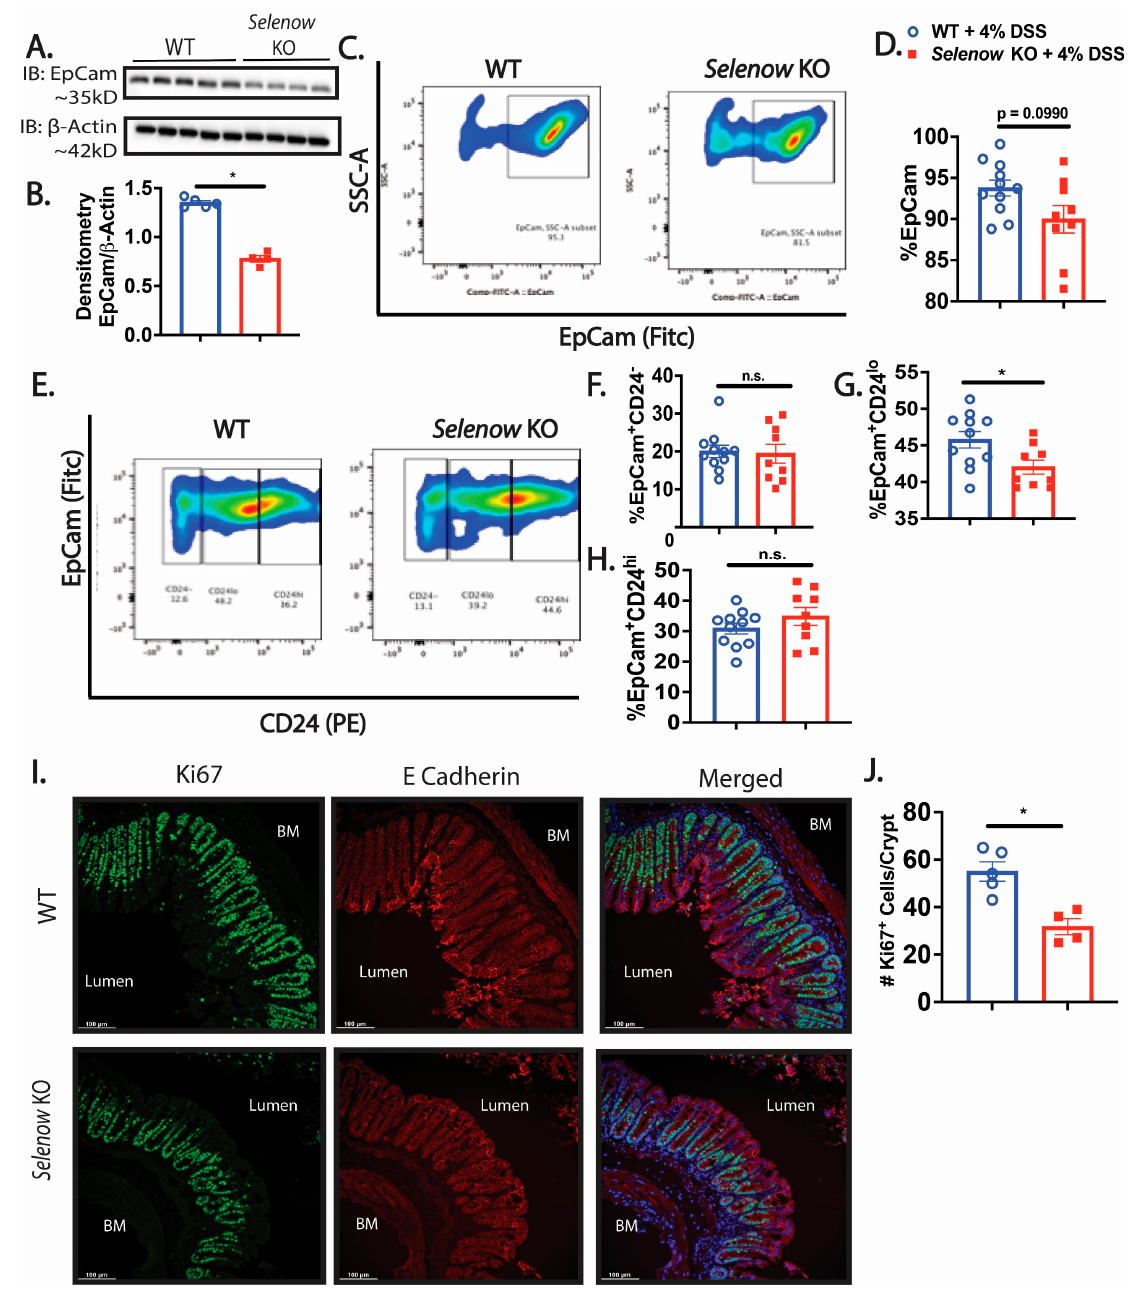
Figure 5. Decreased cycling epithelial cells following injury in Selenow KO mice. ( A ) Representative immunoblot of EpCam and ( B ) quantification of EpCam from colonic lysates of WT and Selenow KO mice at day 8 post DSS (WT = 5 mice; Selenow KO = 4). ( C ) Representative flow plot and ( D ) percentage of epithelial (EpCam + ) cells isolated from the intestinal epithelium of WT and Selenow KO mice at day 8 post DSS (WT = 11 mice; Selenow KO = 9). ( E ) Representative flow plot and ( F-H ) percentage of EpCam + CD24 − , EpCam + CD24 hi and cycling cells (EpCam + CD24 lo ) isolated from the intestinal epithelium of WT and Selenow KO mice at day 8 post DSS (WT = 11 mice; Selenow KO = 9). ( I ) Representative immunofluorescent image (20× magnification; scale bar = 100 μ m; BM: basement membrane) and ( J ) quantification of the number of Ki67 + cells (green: AF488) per crypt (co-stained with E Cadherin (red: AF594) of WT and Selenow KO mice at day 8 post DSS (WT = 5 mice; Selenow KO = 4). Data indicate mean ± SEM. ( B , D , F – H , J ) Unpaired non-parametric Mann–Whitney test. * p < 0.05, n.s., not significant.